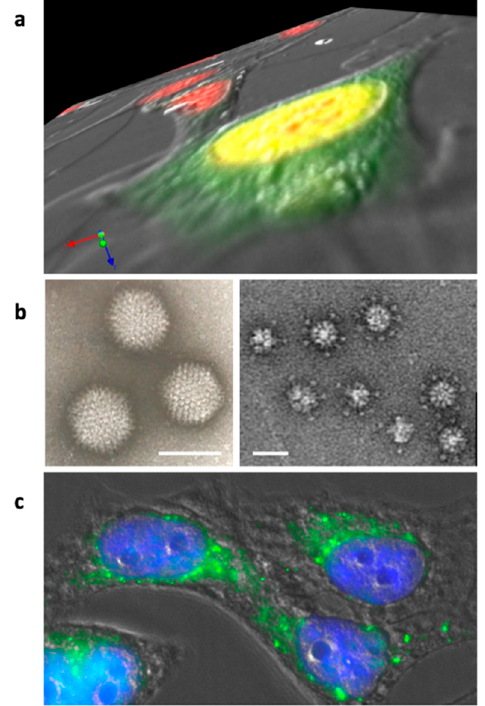
Figure 2. Adenovirus dodecahedron formation and internalization. ( a ) Z-series of Hela cells infected for 16 h by wt-HAdV3. Nuclei are stained in red and the penton base is detected in green. The penton base is synthesized in the cytoplasm and transported to the nucleus (yellow results from superposition of the red and green signals) where dodecahedron assembly takes place. ( b ) Electron microscopy images of the purified adenovirus and (Pt-Dd) ‘penton dodecahedrons’ (bars: 90 and 30 nm, respectively). ( c ) Hela cells incubated with recombinant Pt-Dd for 1 h. Cell shapes were observed by DIC, nuclei are stained in blue, and Pt-Dd are detected in green.